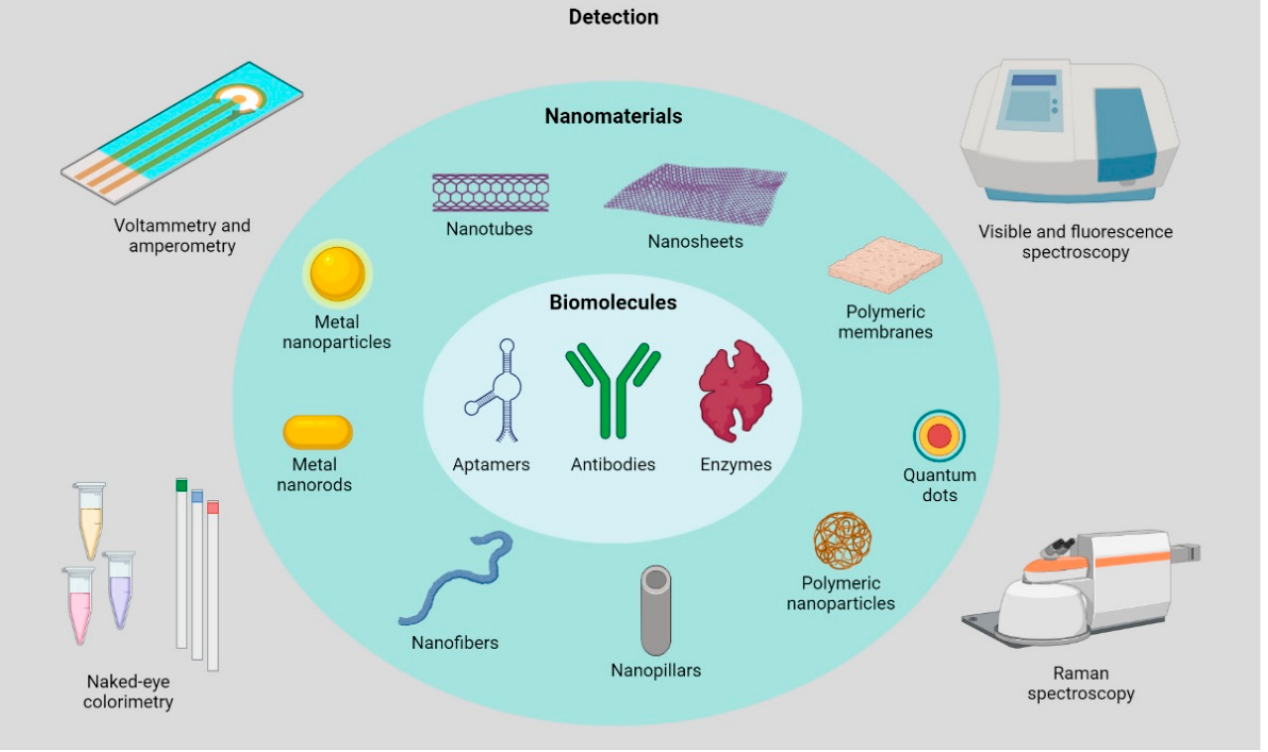
Figure 1. Schematic overview of the main biological, organic and inorganic components and detection strategies reported in this review. The image has been created with BioRender.com.